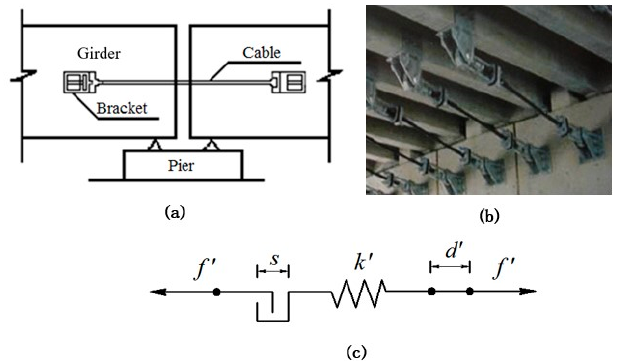
Figure Figure 4. Different forms of cable unseating prevention devices and finite element model: ( a ) girder- to-girder form, ( b ) pier-to-girder form, ( c ) finite element model of cable unseating prevention devices.